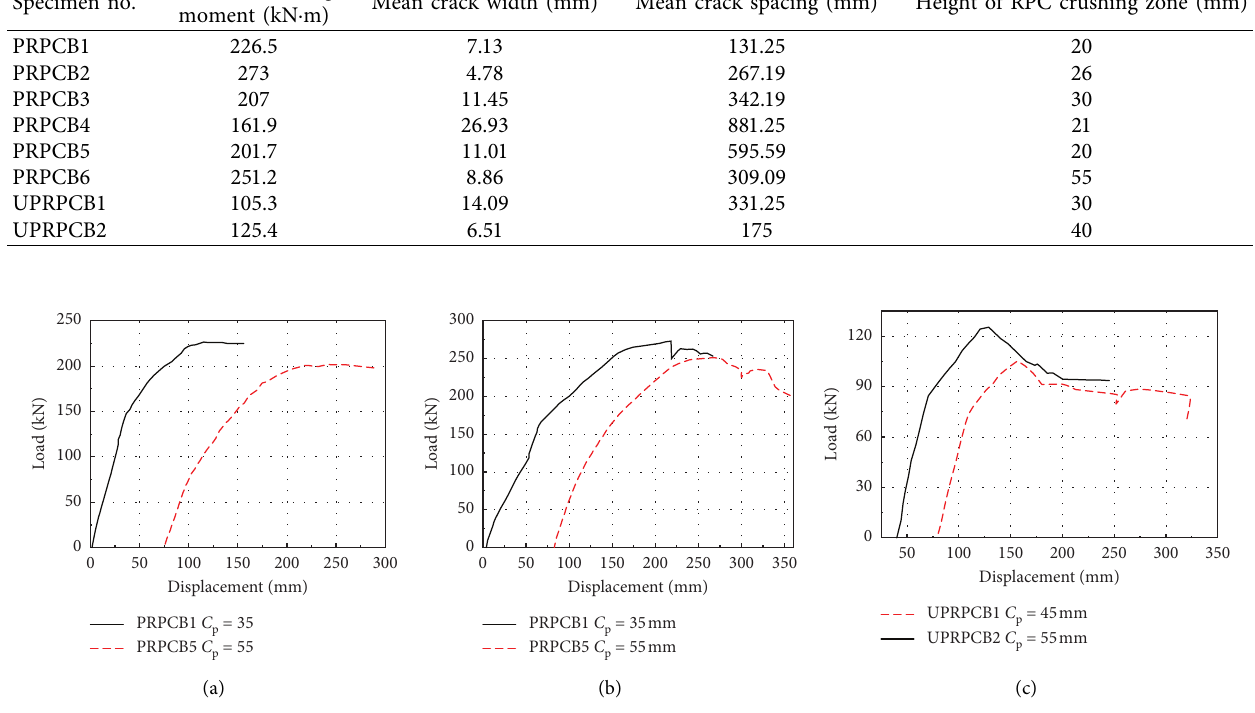
Figure 15: Midspan deformation curves of the specimens with different cover thickness. (a) PRPCB1 and PRPCB5. (b) PRPCB2 and PRPCB6. (c) UPRPCB1 and UPRPCB2.